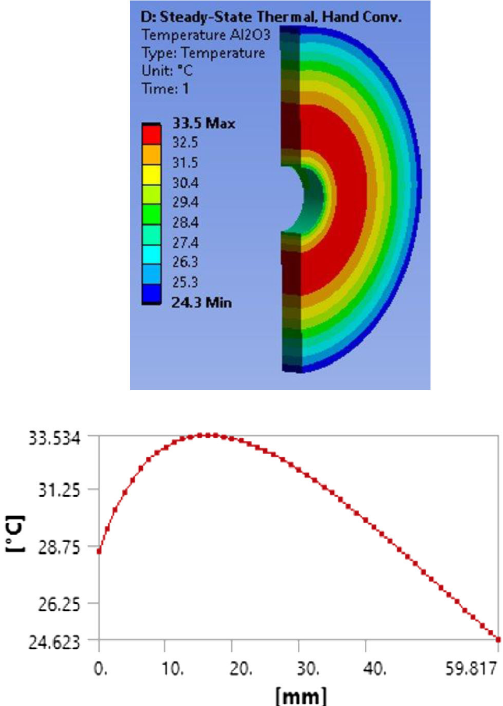
FIG. 13. Temperature profile on Al 2 O 3 (top) and temperature distribution along Al 2 O 3 radius (bottom).